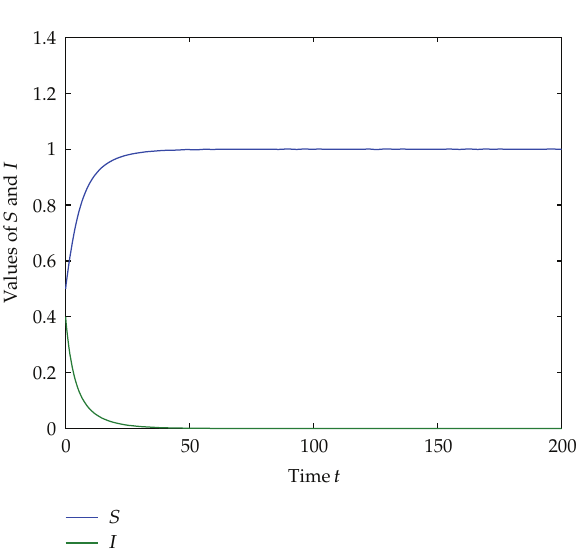
Figure 2: Evolutions of S (cid:5) t (cid:6) and I (cid:5) t (cid:6) for the system with β (cid:8) 0 . 3, δ (cid:8) 0 . 1, α 1 (cid:8) 0 . 2, α 2 (cid:8) 0 . 4, γ 1 (cid:8) 0 . 1 and (cid:8) 0 . 2, provided S (cid:5) 0 (cid:6) (cid:8) 0 . 5 and I (cid:5) 0 (cid:6) (cid:8) 0 . γ 2